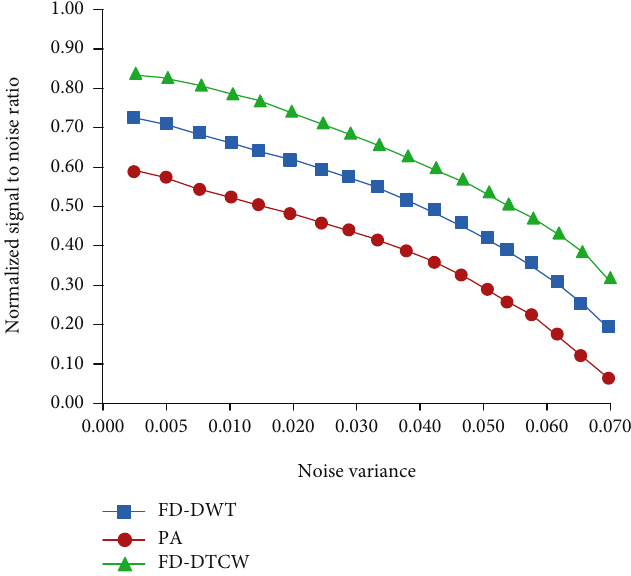
Figure 13: Signal to noise ratio change of each model on FAIR1M test set.